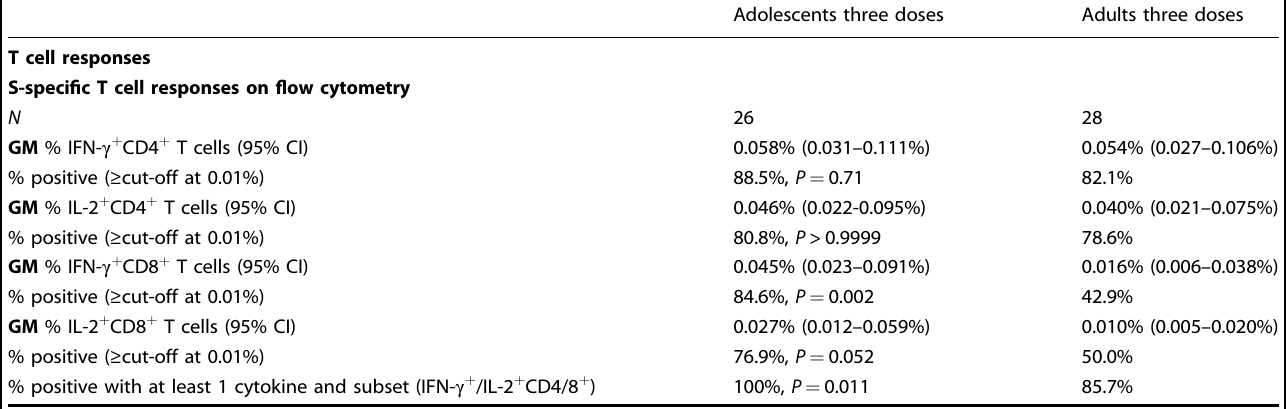
Table 2. Cellular immunogenicity outcomes against wild-type SARS-CoV-2 after the third dose of BNT162b2 in the evaluable analysis